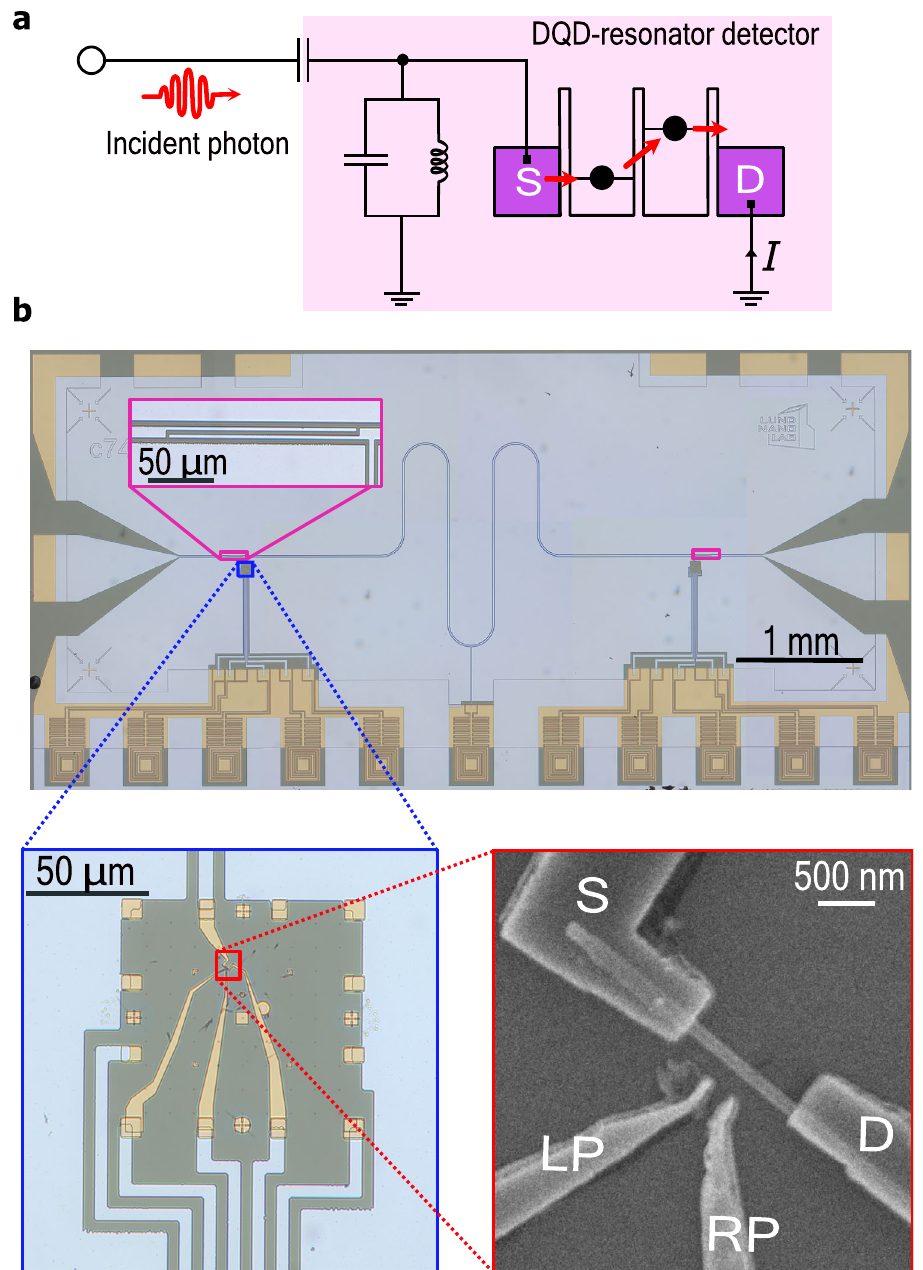
Fig. 1 Device architecture. a Schematic of the detector operation: a photon in the transmission line is incident on the detector (pink shaded), consisting of a DQD embedded in a microwave resonator. With large ef fi ciency, the photon is absorbed in the DQD, causing an electron to tunnel through the DQD, producing an electrical current I . b Optical image of the photodetector highlighting the superconducting microwave resonator made out of aluminum. The two zoom-ins (one optical and one scanning electron micrograph) depict the DQD and its connections to the resonator and measurement